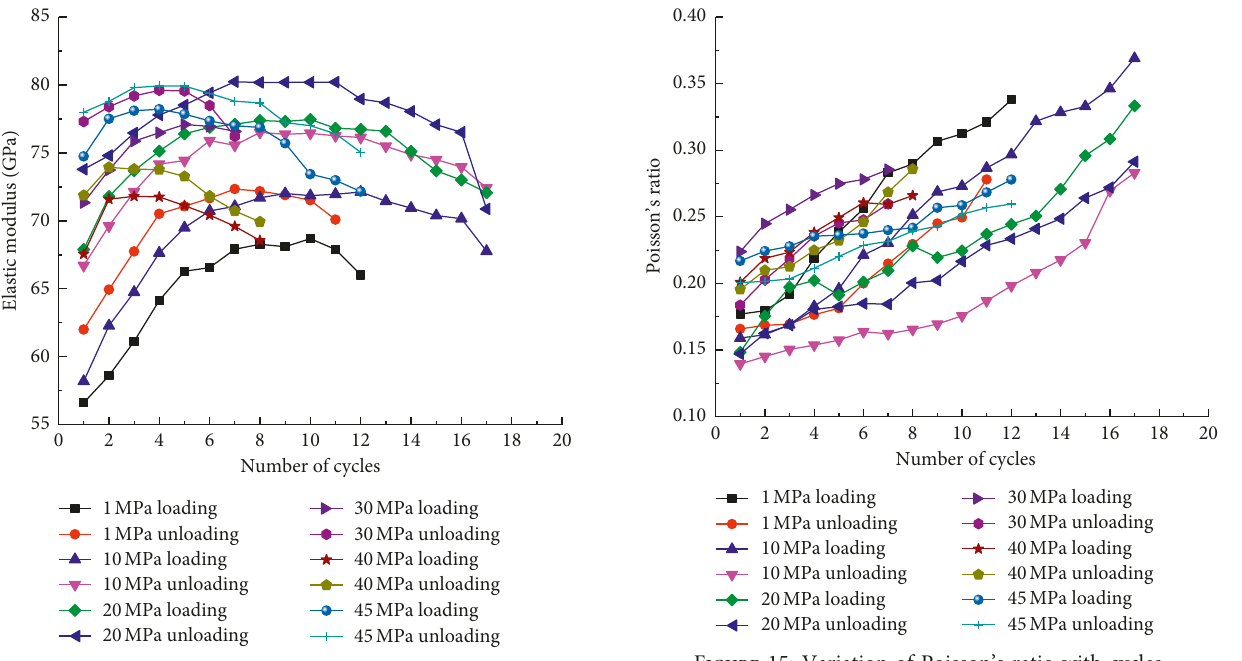
Figure 14: Variation of elastic modulus with cycles.